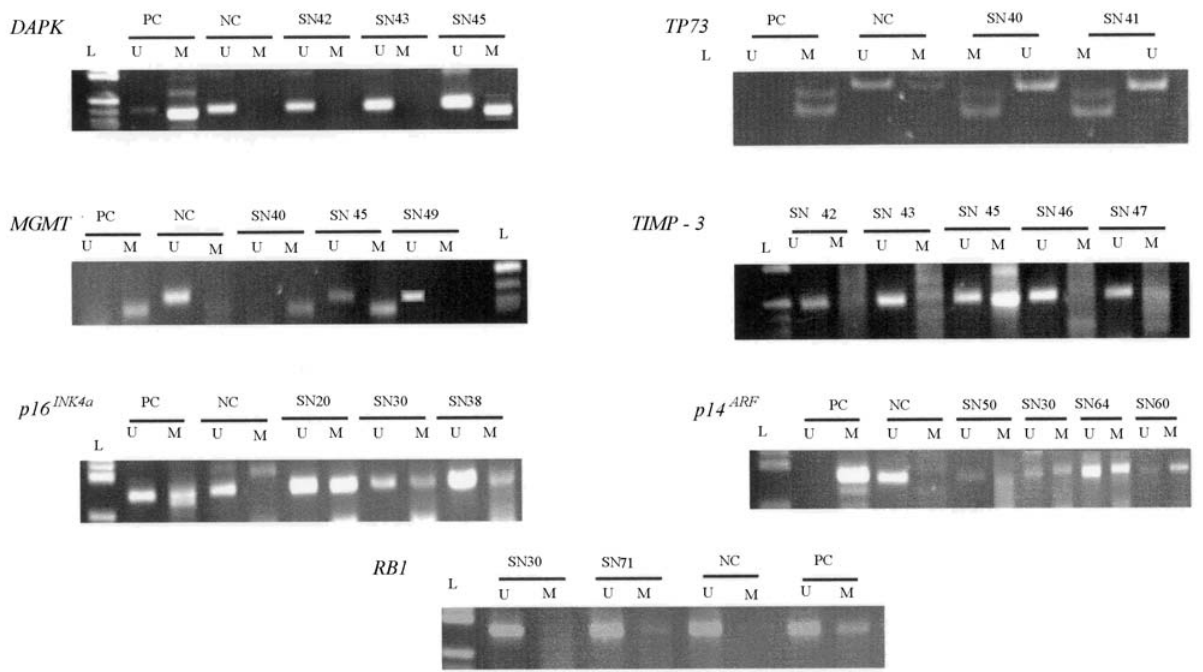
Figure 1 - Methylation analysis by MSP in brain tumors. The studied gene is given on the left of each panel. Lane U = amplified product with primers recognizing unmethylated sequences; Lane M = amplified product with primers recognizing methylated sequences. PC = positive control (DNA treated with methylase); NC = negative control (DNA of non malignant tissue); L =